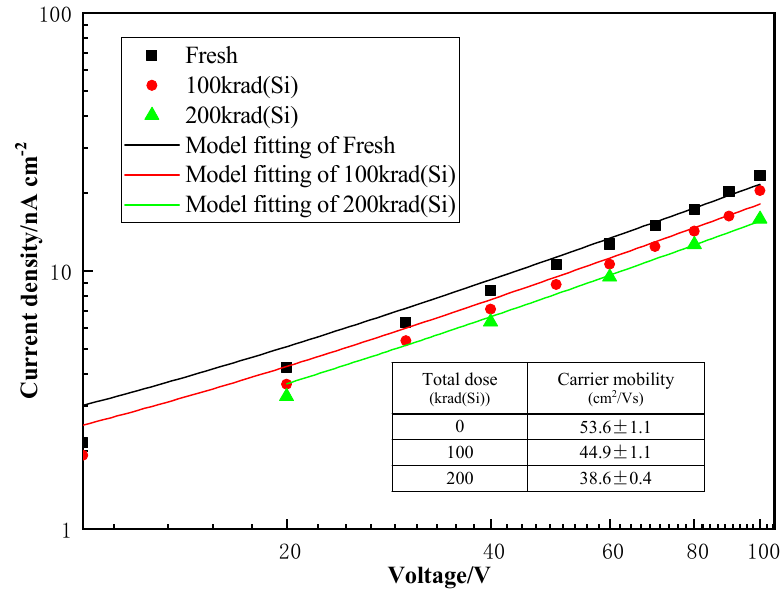
Figure 4. The J-V characteristics and its tendency fit according to the diffusion model. Accordingly, the J-V curve under the reverse bias of an MSM device was fitted accord- ing to the above J-V equation, as plotted in Figure 2. The J–V curve in the measured range followed the tendency predicted by the diffusion model. Before irradiation, the Schottky barrier extracted was 0.72 eV, while u is 53.6 cm 2 /Vs. Following irradiation, the Schottky barrier was not changed, while the µ was dropped with the total dose, and 44.9 cm 2 /Vs for 100 krad(Si) 38.6 cm 2 /Vs for 200 krad(Si). Thus, we considered that the radiation induced defects in the CsPbBr3 detector and is the main reason for the decrease in mobility. The total ionizing dose impacted the photoelectric response of the CsPbBr 3 detector. Figure 5 shows the time-dependent currents under the light pulses and 50 V bias. The dark current was about 0.7–1.9 nA. Before radiation, the photocurrent was around 85 nA, and the ON-OFF ratio was about 80. Then, with the increase in total dose, the photocurrent and the ON-OFF ratio dropped. For the total dose of 200 krad(Si), the photocurrent was around 32 nA, and the ON-OFF ratio was reduced to 35. Therefore, this finding indicates that electrical-active defects were likely formed after total irradiation, resulting in the trapping of photo-generated